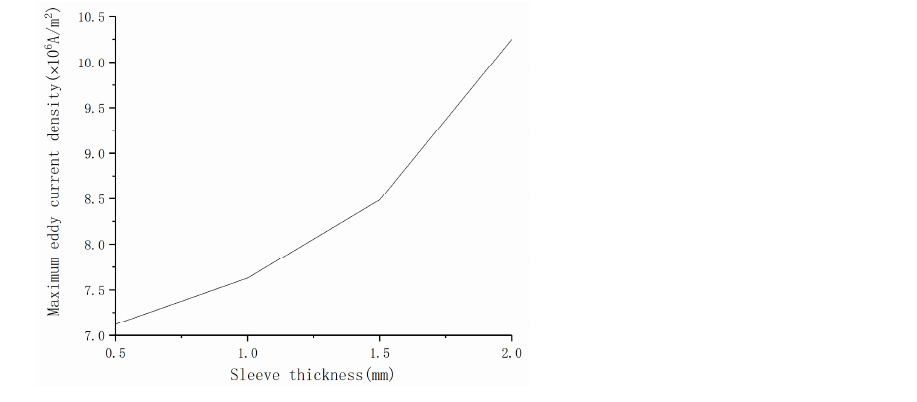
Figure 15. The trend of the maximum eddy current density of the sleeve with different thicknesses.